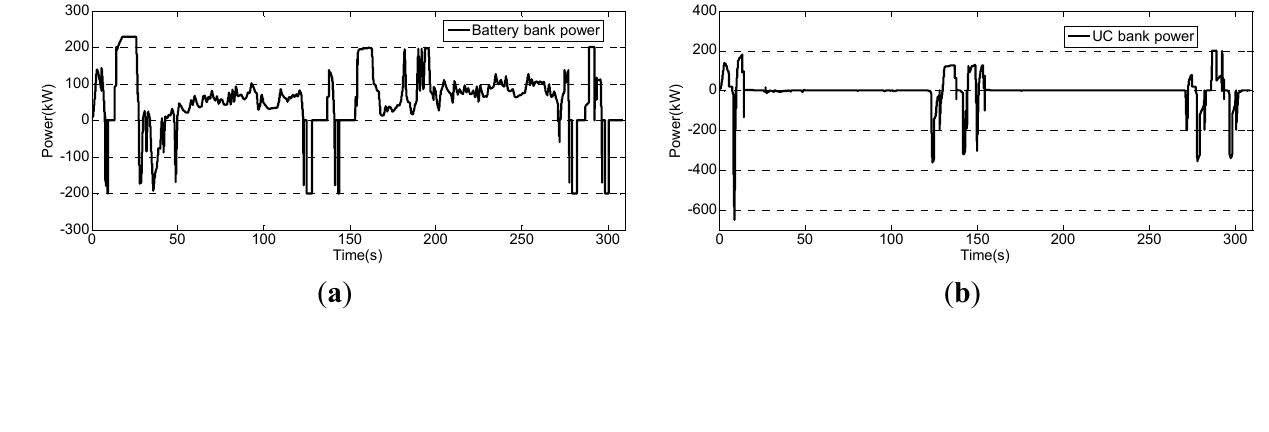
Figure 14. Simulation results with a 200 kW power limit on the DC-DC converter: ( a ) battery bank power; ( b ) UC bank power; ( c ) mode; ( d ) bi-directional DC-DC converter power; ( e ) voltage of the battery bank and the UC